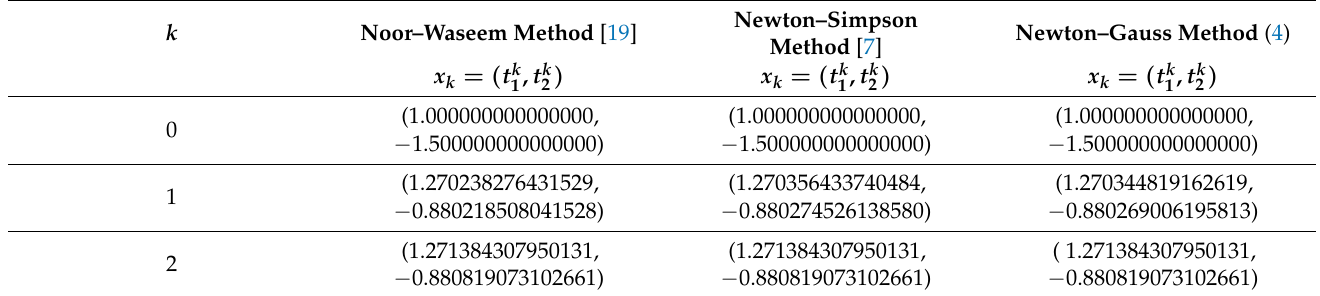
Table 6. Method—Order